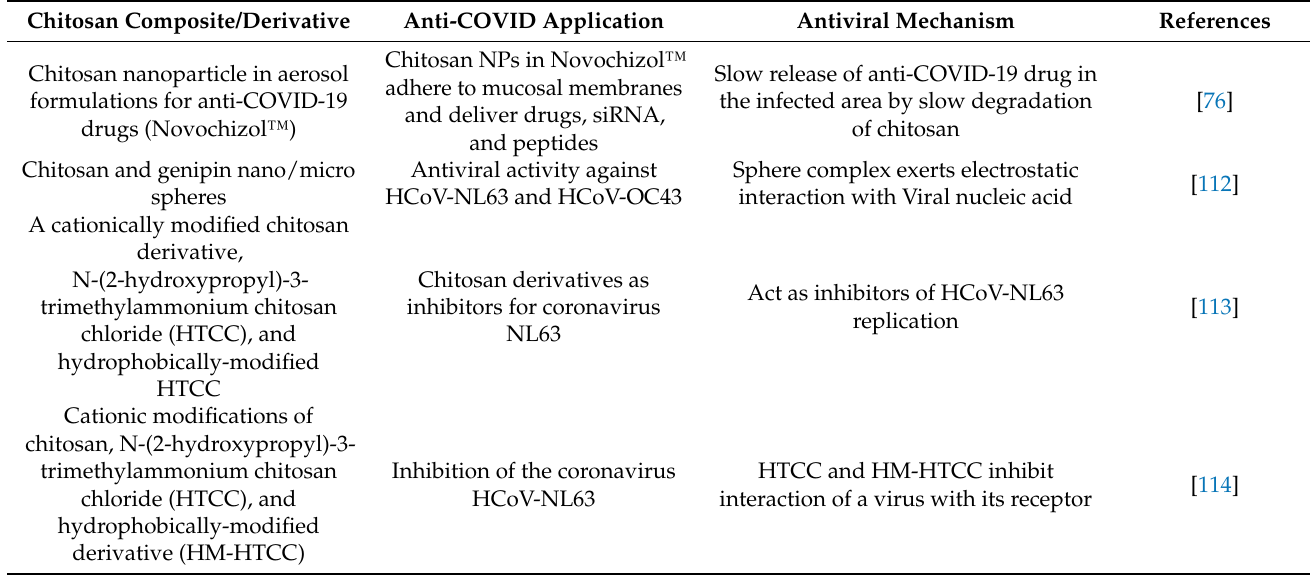
Table 1. Anti-COVID 19 applications of chitosan